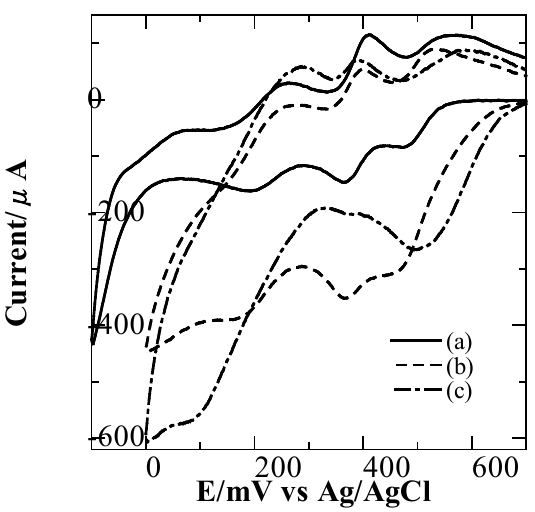
Figure 5. Cyclic voltammograms of a 100 mM Mo(VI)–10 mM As(V)–10 mM V(V)–0.5 M HCl system collected (a) after a solution without V(V) was heated at 80 °C for 7 h, (b) immediately after 10 mM V(V) was added to solution (a) and subsequently heated at 80 °C for 2 h and (c) after solution (b) was heated at 80 °C for one